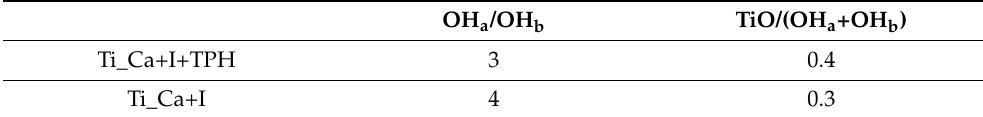
Table 2. The ratio of the peak area of the XPS curves for the Ti_Ca+I+TPH and Ti_Ca+I samples. OH a /OH